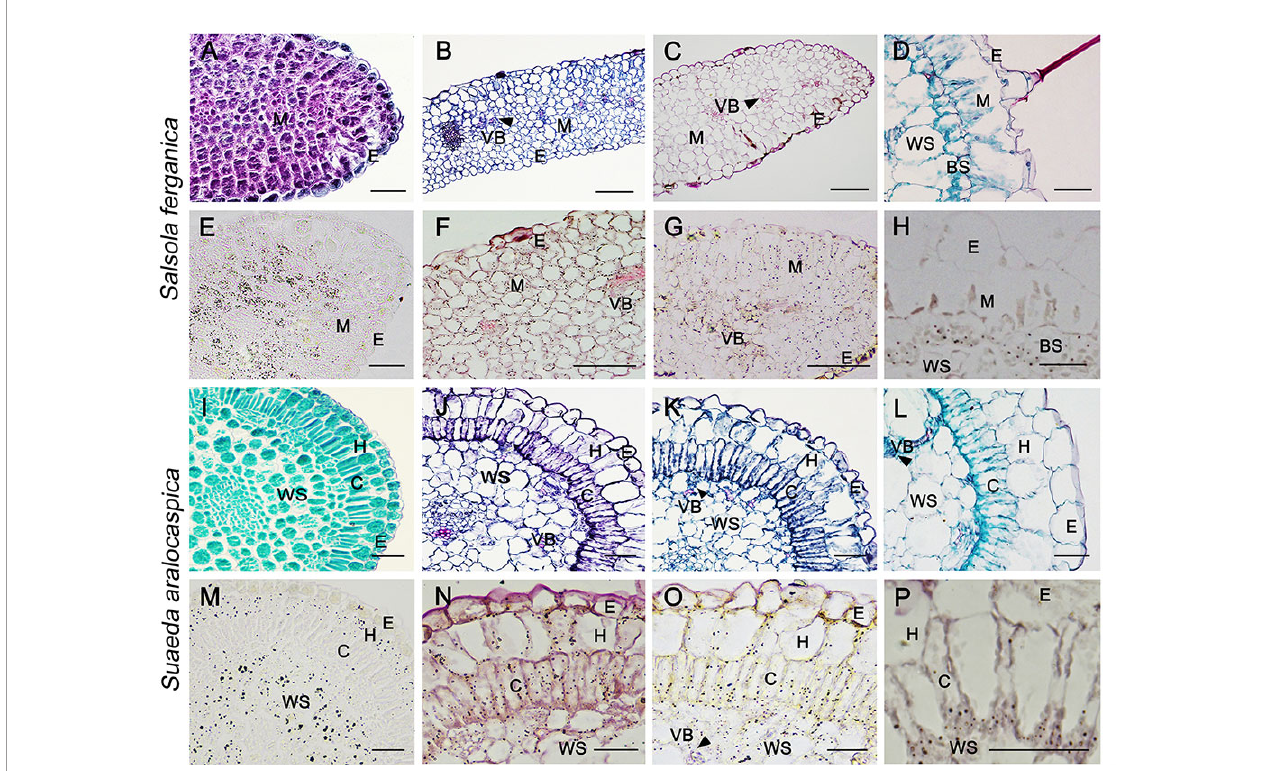
FIGURE 2 | General anatomy (upper panel) and starch localization (lower panel) in developing cotyledon and true leaf of S. ferganica and S. aralocaspica. (A, E, I, M) Cotyledon, 0 d; (B, F, J, N) Cotyledon, 4 th d; (C, G, K, O) Cotyledon, 8 th d; (D, H, L, P) Mature leaf. BS, bundle sheath; C, chlorenchyma; E, epidermis; H, hypodermis; M, mesophyll; VB, vascular bundle; WS, water storage. Scale bar is 50 m